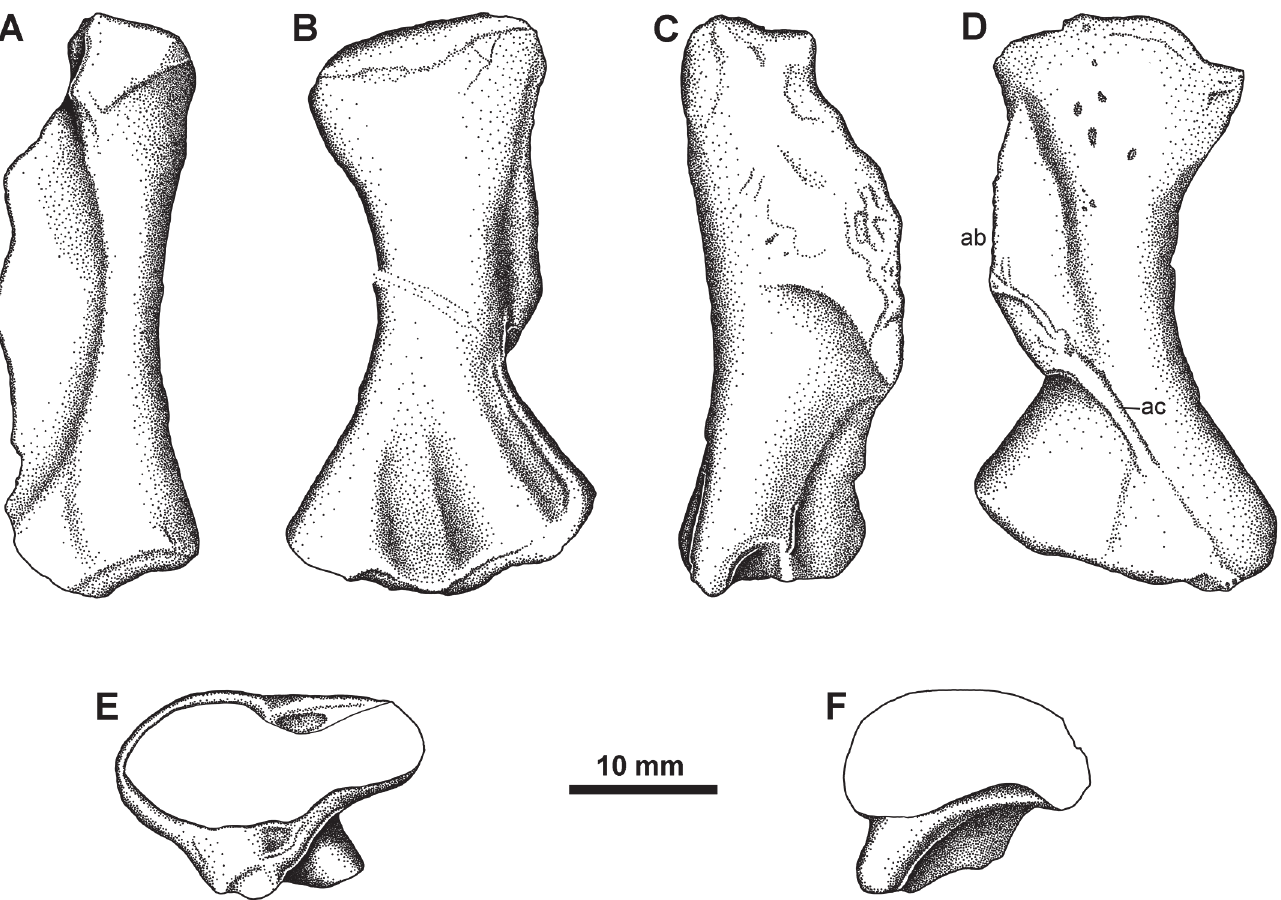
Fig 10. Femur Type 3. NSM007GF004.629, left femur (reversed for comparison) in A, posterior, B, dorsal, C, anterior, and D, ventral views. Abbreviations : ab , adductor blade; ac , adductor